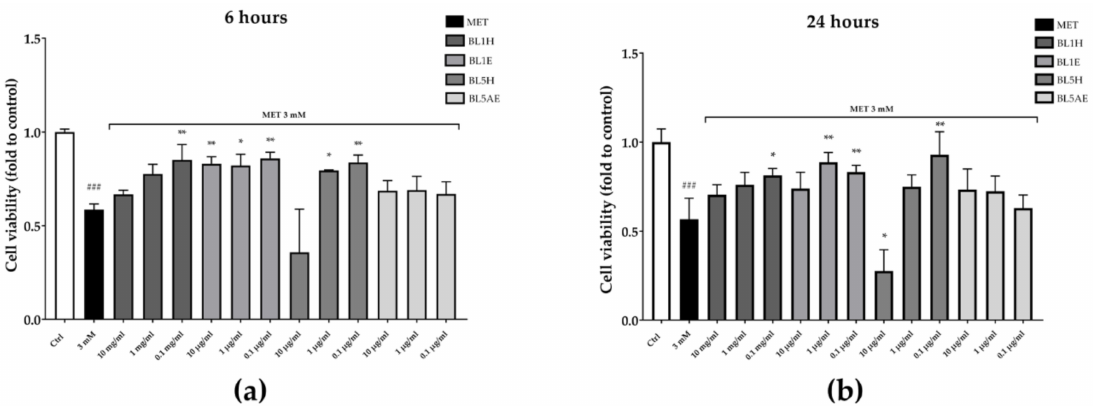
Figure 9. Protection from MET-impaired cell viability by BL1 and BL5 honeys and extracts after six hours ( a ) and 24 hours ( b ). * p < 0.05 vs. stimulus; ** p < 0.01 vs. stimulus; ### p < 0.001 vs.